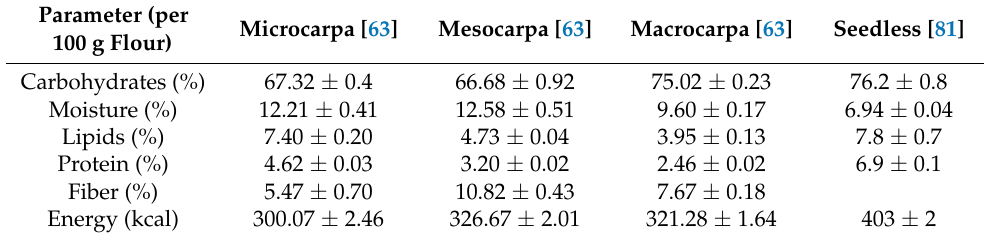
Table 5. Nutritional parameters, B. gasipaes